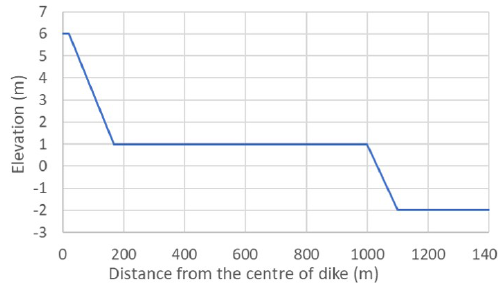
Figure 5. Cross section for the 1-D network on the seaside.